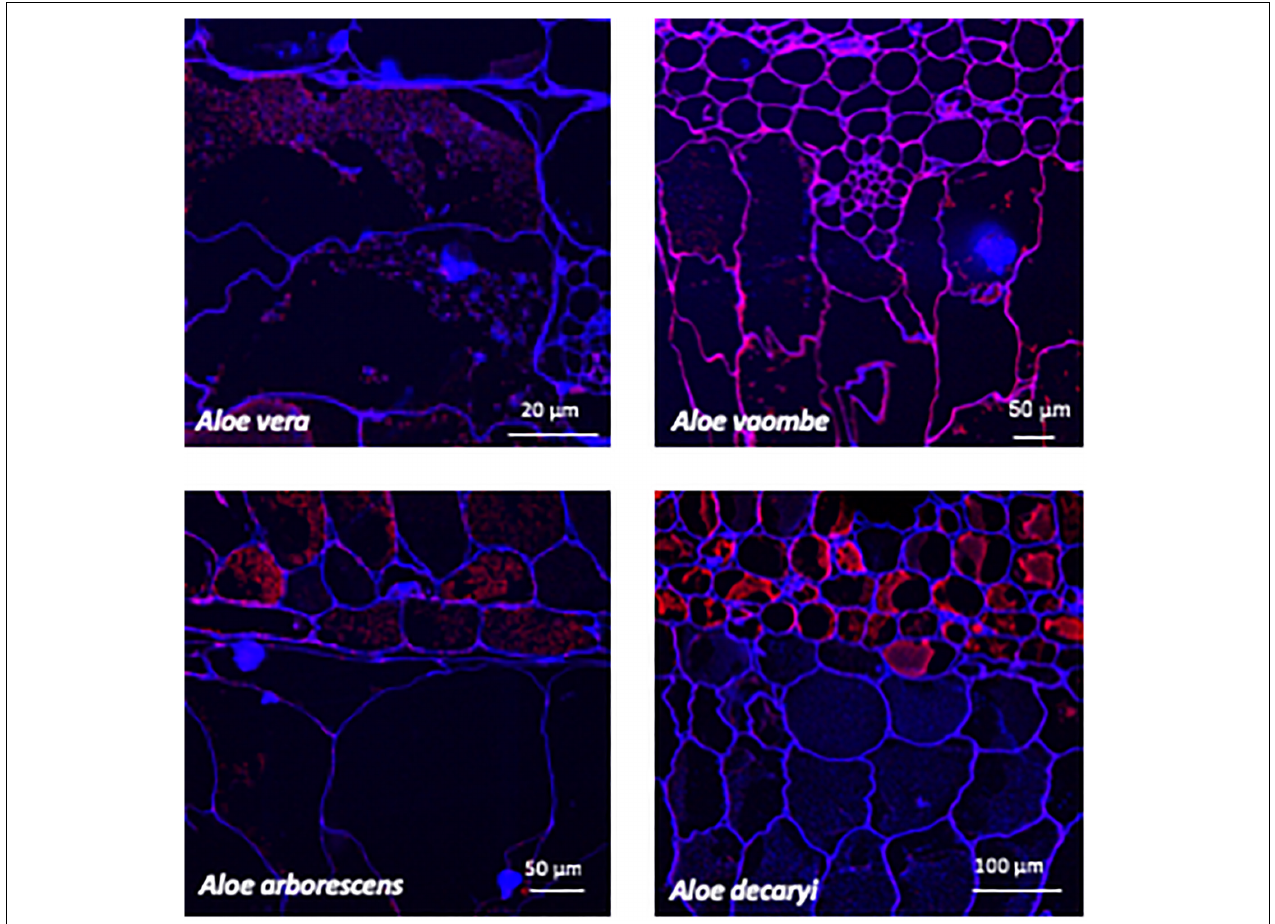
FIGURE 5 | Immunolabeling using the mannan specific monoclonal antibody LM21 (red channel). Overlay with Calcofluor White (blue channel) counterstain to visualize cell walls.